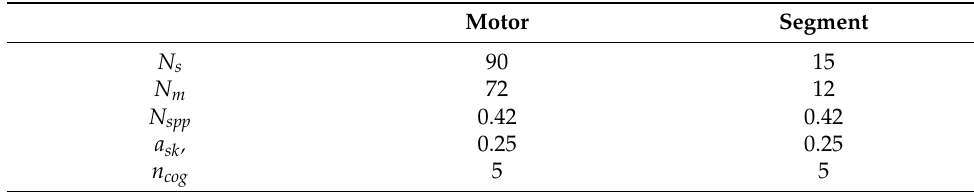
Table 3. Motor and Segment